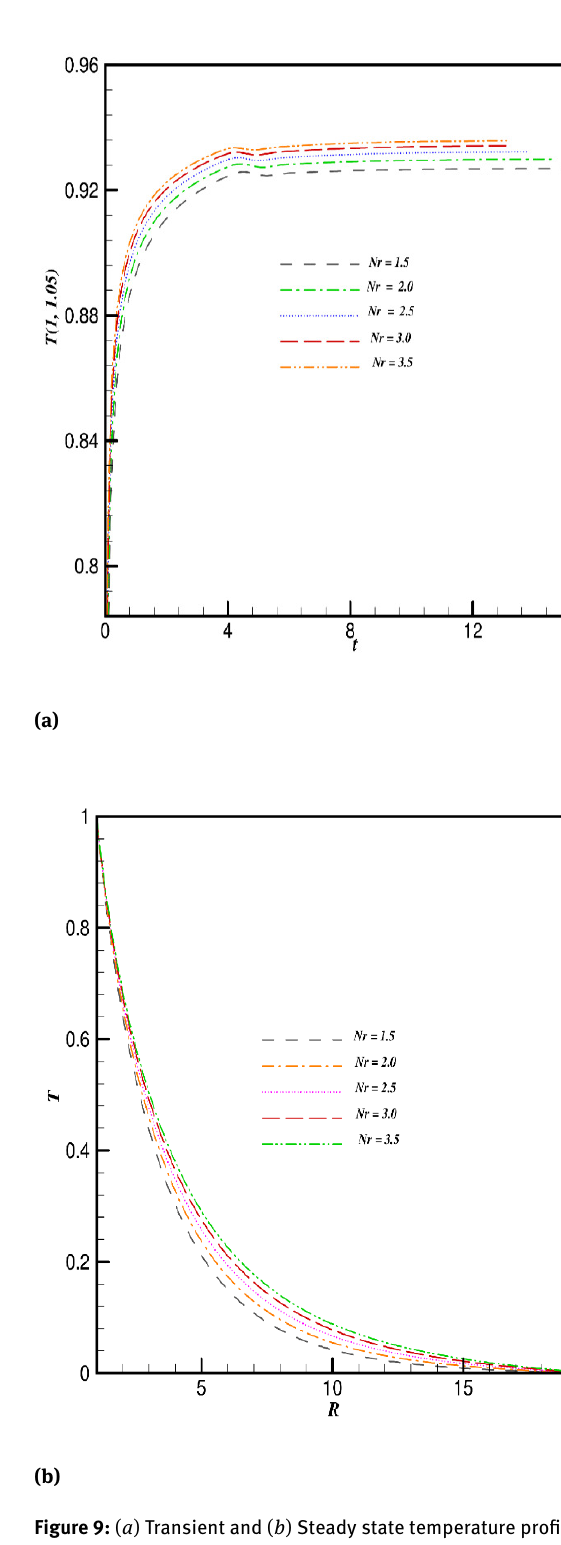
Figure 8: ( a ) Transient and ( b ) Steady state velocity profiles with fixed Sc = 0.6 , Pr = 0.7 , Bu = 1.0 , Kr = −0.2 , K 1 = 1.0 , M = 0.2 , Ec = 0.1 .